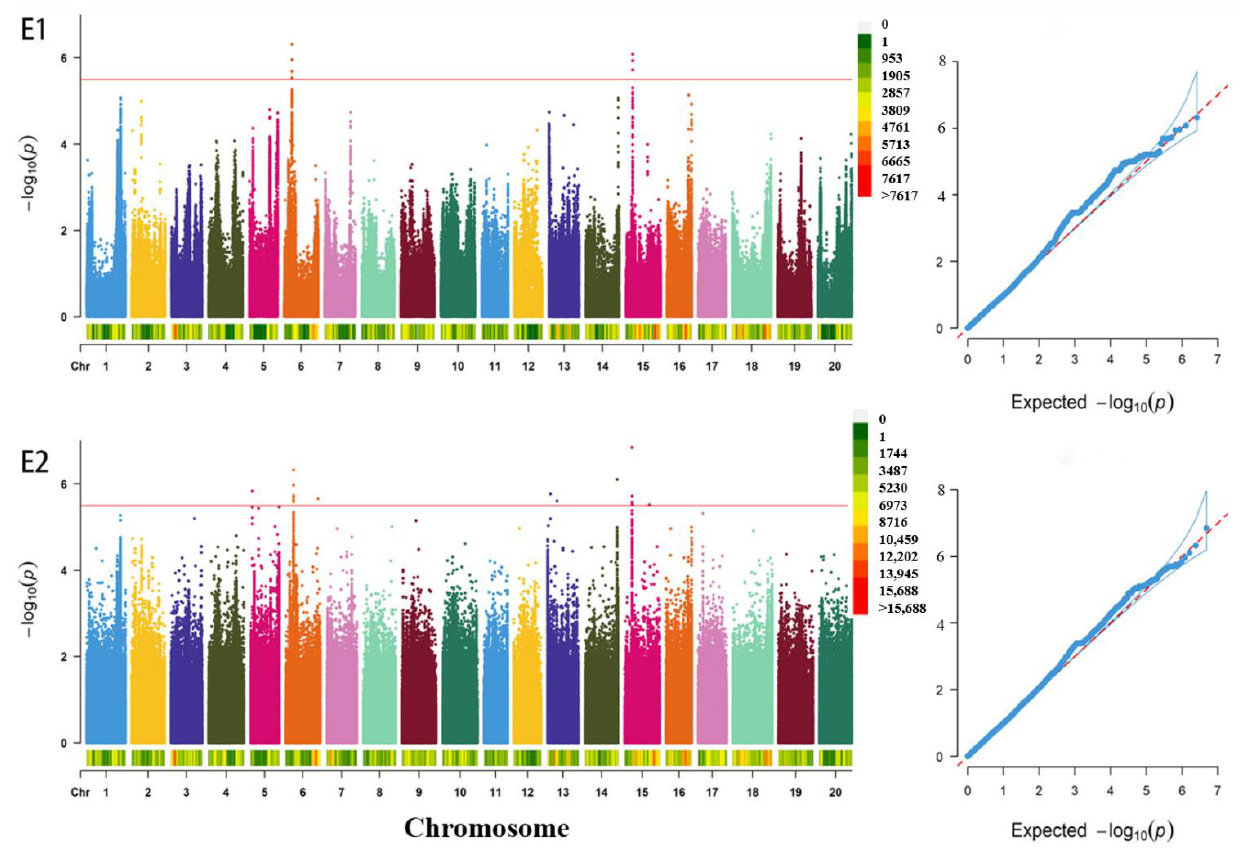
Figure 2. Manhattan plots and quantile-quantile for the GWAS for soluble sugar in E1 and E2. a E1: total soluble sugar in 2019; b E2: total soluble sugar in 2020. The red line indicates the significance threshold ( − log 10 ( p ) = 5.5) (color figure online). Table 1. SNPs significantly associated with total soluble sugar in two years based on GWAS.